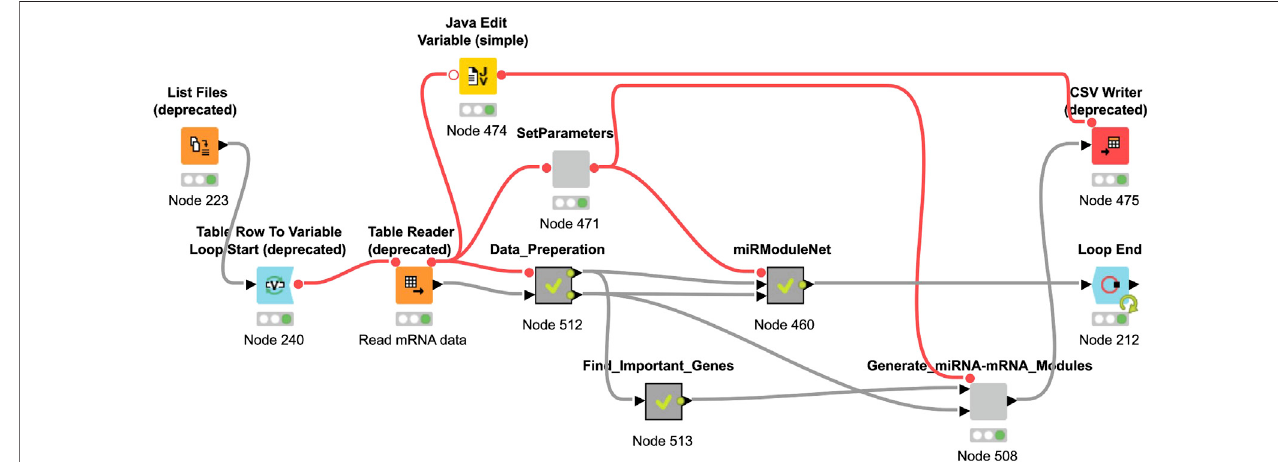
FIGURE 5 | miRModuleNet work fl ow in KNIME.